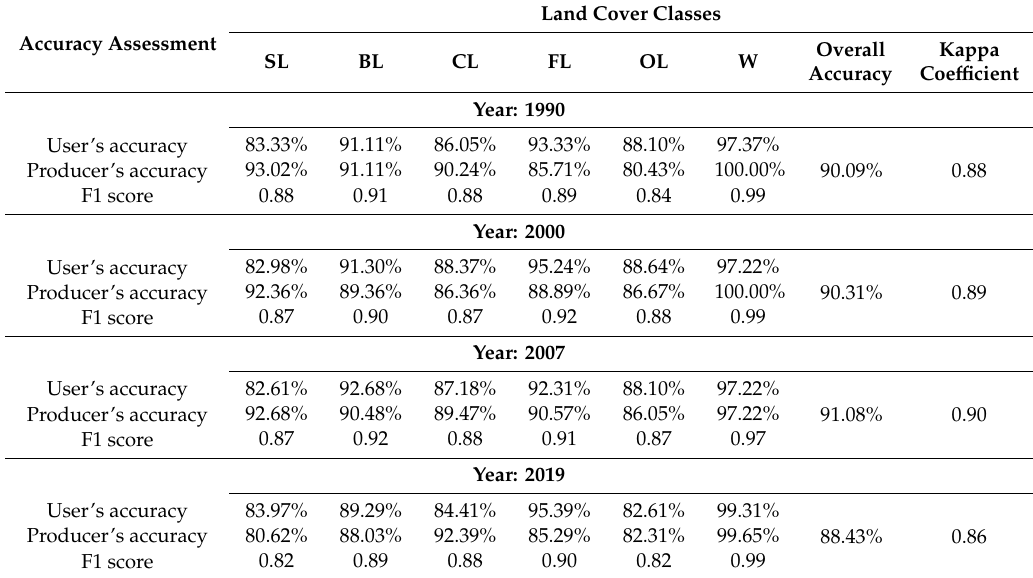
Table 3. User’s accuracy, producer’s accuracy, overall accuracy, and Kappa coe ffi cient on Haitan Island, China, by land cover classes.